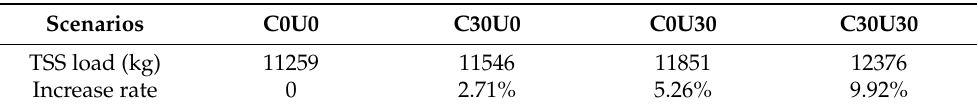
Table 5. TSS load under different future